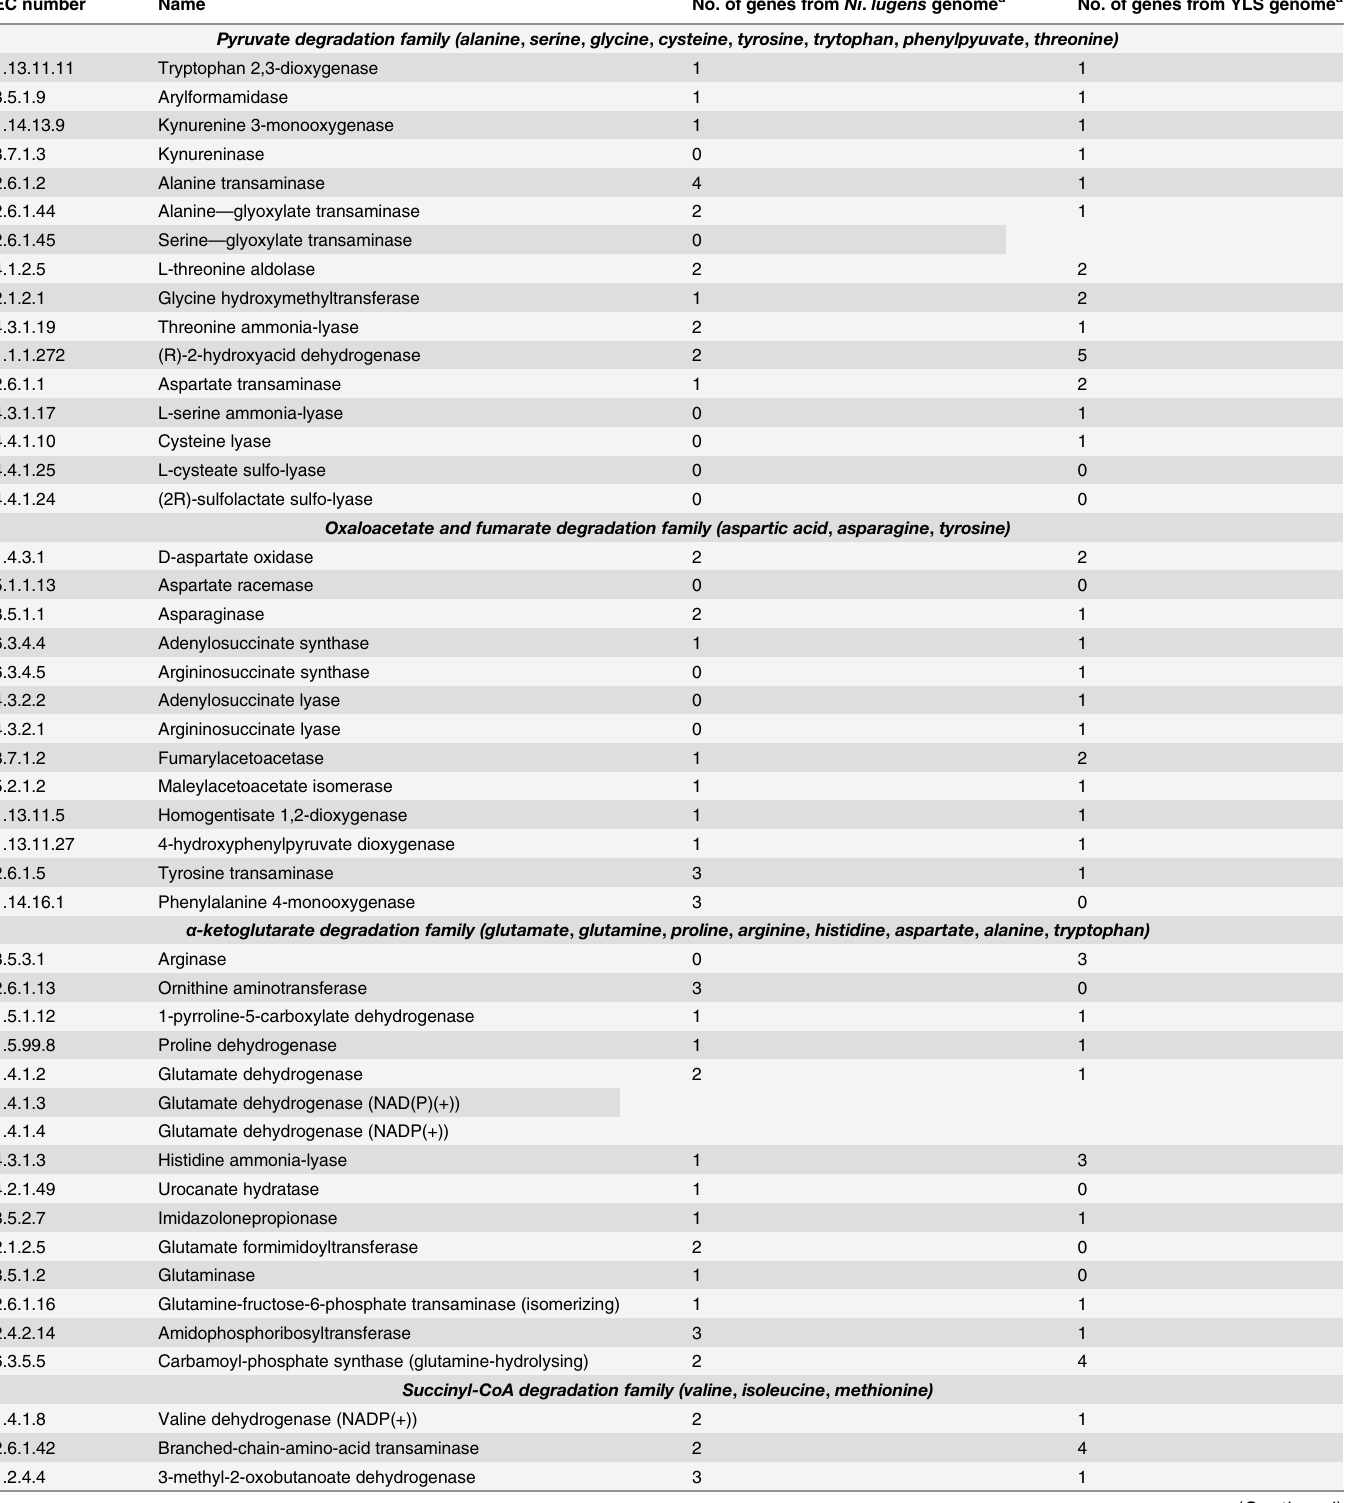
Table 1. Counts of identified genes from Ni . lugens and YLS